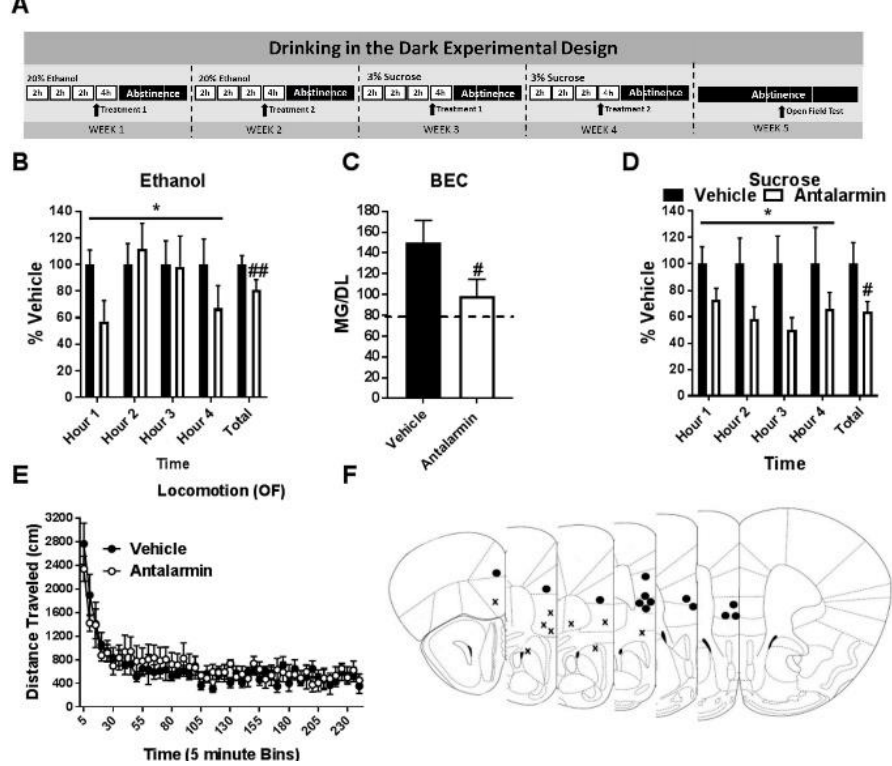
Figure 1. Corticotropin releasing factor receptor 1 (CRF1R) antagonism in the medial prefrontal cortex (mPFC) blunts binge intake without altering general locomotion. ( A ) Experimental